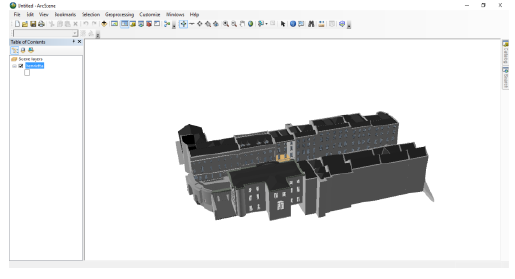
Figure 7: Original SketchUp model displayed in ArcScene